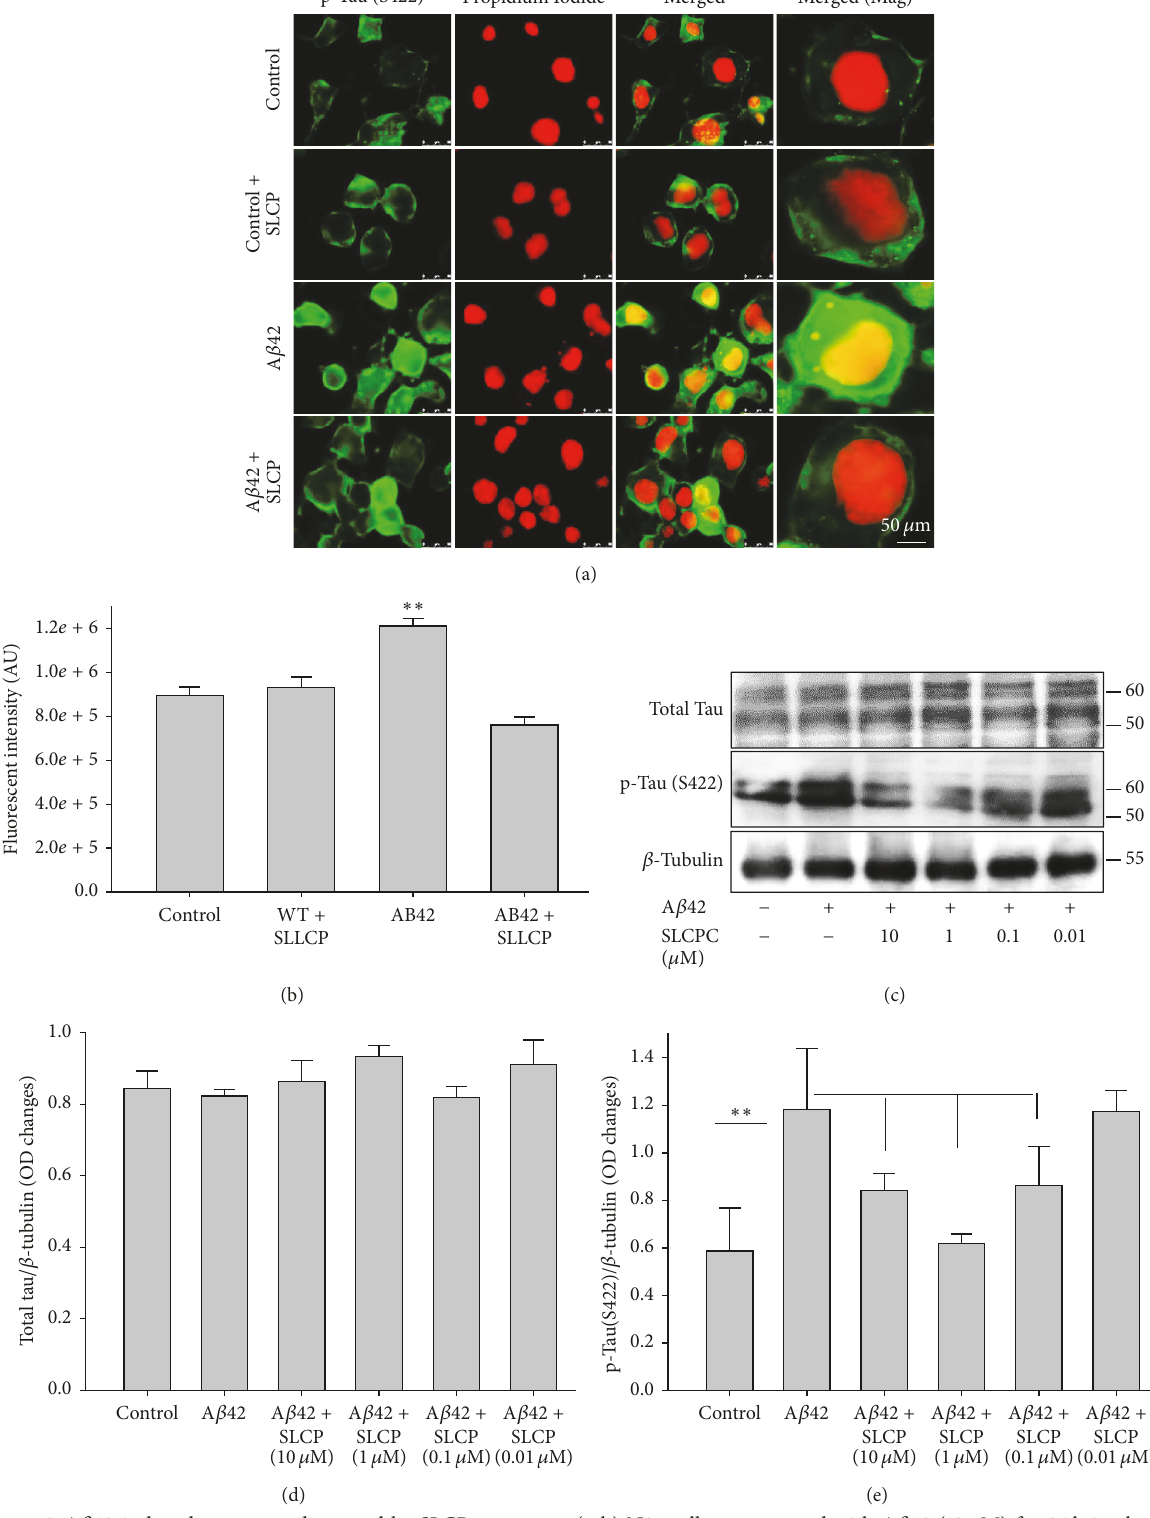
Figure 6: A 𝛽 42-induced p-tau was decreased by SLCP treatment. (a-b) N2a cells were treated with A 𝛽 42 (10 𝜇 M) for 24 h in absence or presenceofdifferentconcentrationsofSLCP.Thep-tauimmunofluorescentsignalwassignificantlyincreasedafterA 𝛽 42exposure( ∗∗ 𝑝 < 0.01 relative to control) and normalized by SLCP (1 𝜇 M) treatment. Scale bar indicates 50 𝜇 m and is applicable to all other images. (c–e) Western blot data showed that p-tau (S422) was significantly increased by A 𝛽 42 exposure, whereas SLCP treatment protected against such increase at 10, 1, and 0.1 𝜇 M levels ( ∗∗ 𝑝 < 0.01 , in comparison to all other groups with different concentrations of SLCP treatment, except those given 0.01 𝜇